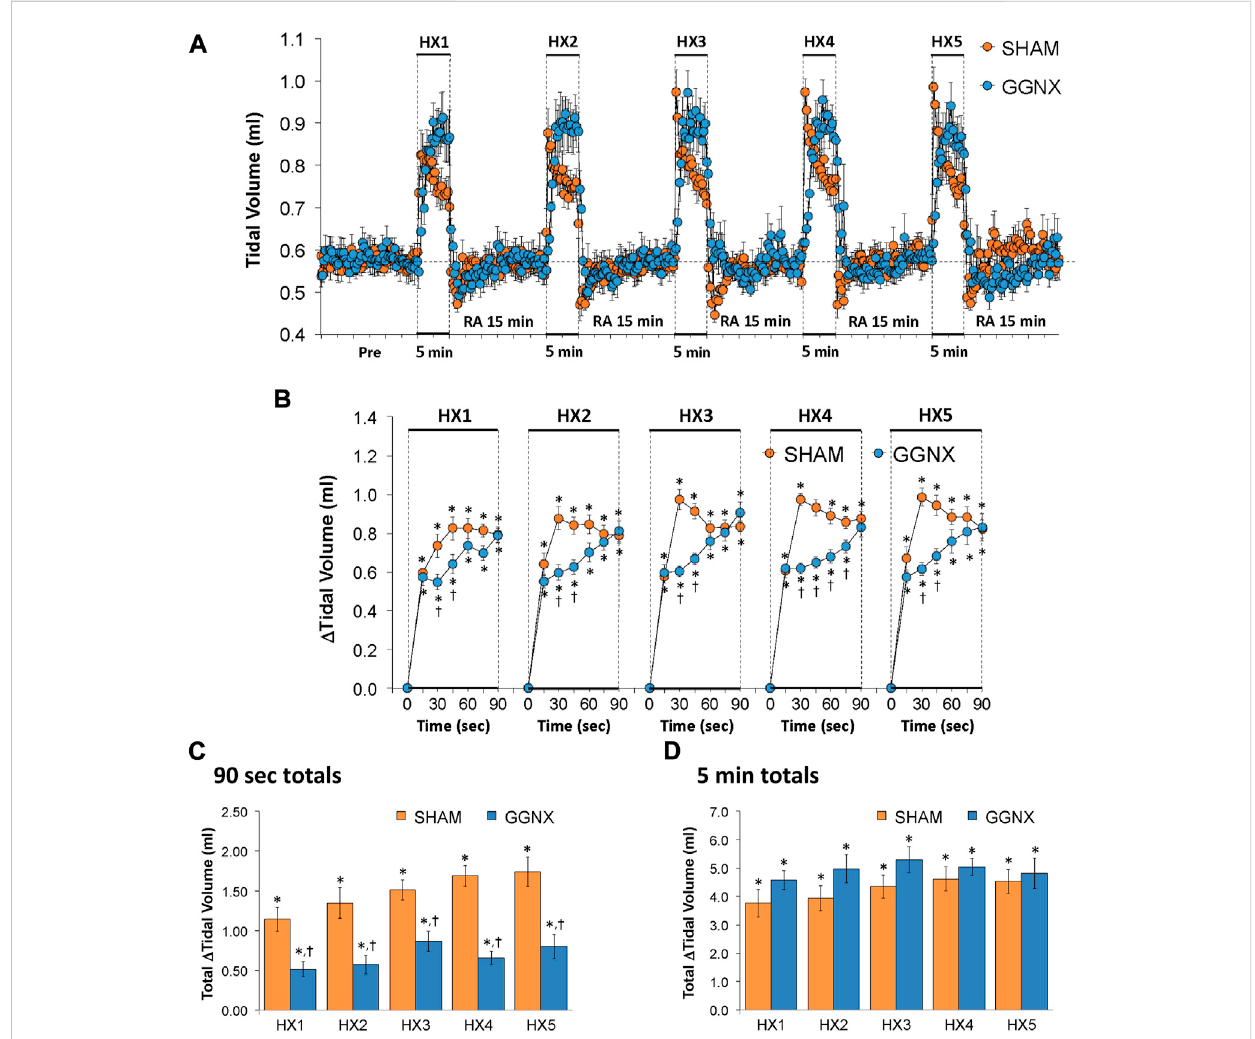
FIGURE 3 (A) Tidal volume in sham-operated (SHAM) rats and in rats with bilateral ganglioglomerular nerve transection (GGNX) before (Pre) and during fi ve hypoxic(HX,10%O 2 ,90%N 2 )gaschallenges,eachseparatedby15 minofroom-air(RA). (B) Arithmeticchangesintidalvolumeduringthe fi rst90 sofHX gas challenge. (C) Total changes in tidal volume during the fi rst 90 s of HX gas challenge. (D) Total changes in tidal volume during the entire 5 min of HX gaschallenge.TheSHAMgrouphad10rats.TheGGNXgrouphad12rats.Thedataarepresentedasmean±SEM.* p < 0.05,signi fi cantresponse. † p < 0.05, GGNX rats versus SHAM